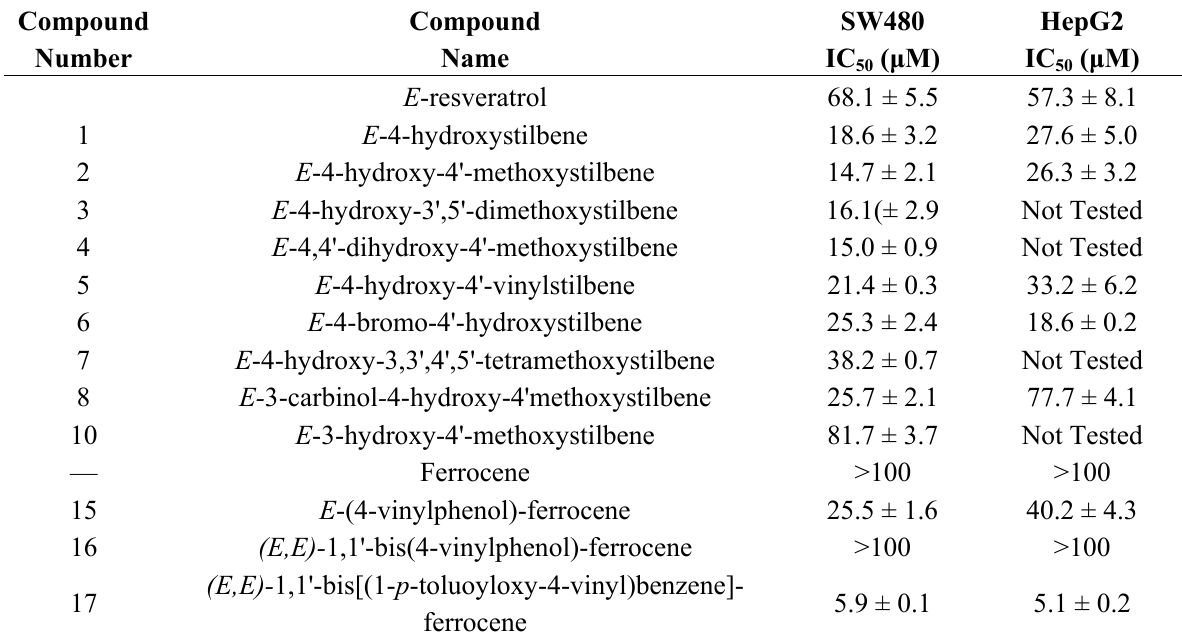
Table 1. Compared IC values of stilbene and ferrocenyl derivatives towards cell 50 proliferation of SW480 and of HepG2 cell lines. For technical informations, see experimental procedure (Cell proliferation